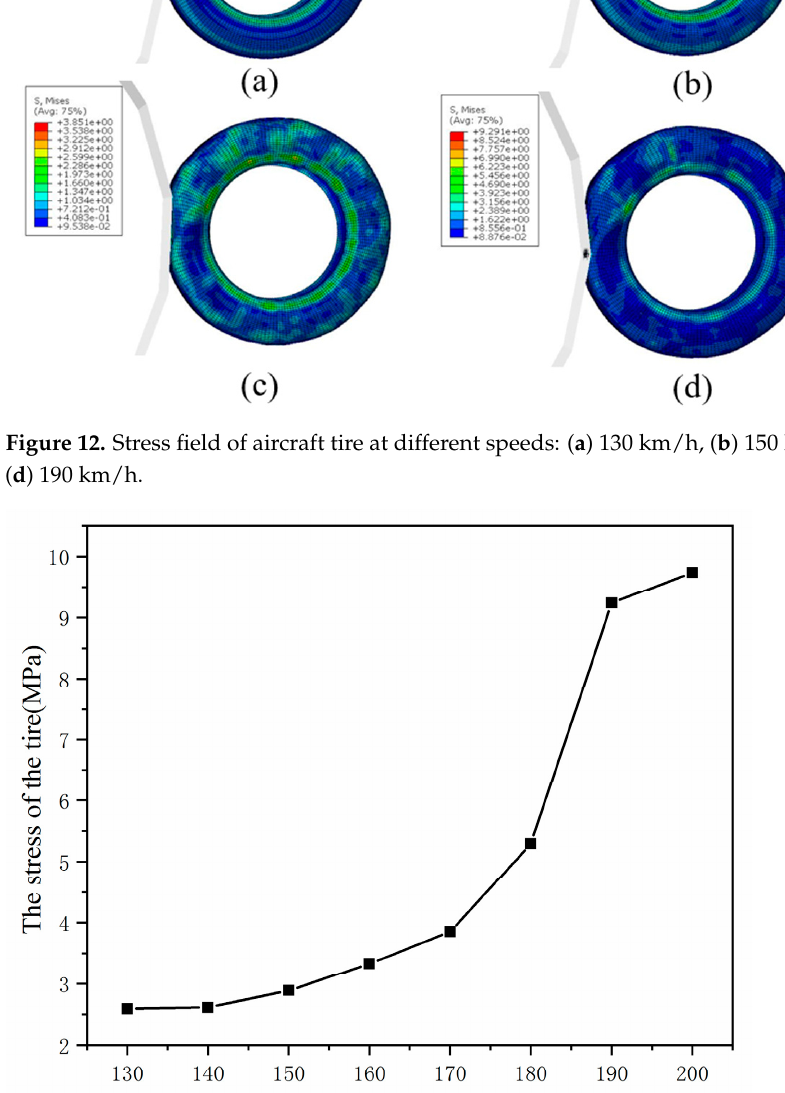
Figure 13. The stress changes of aircraft tire at different speeds.